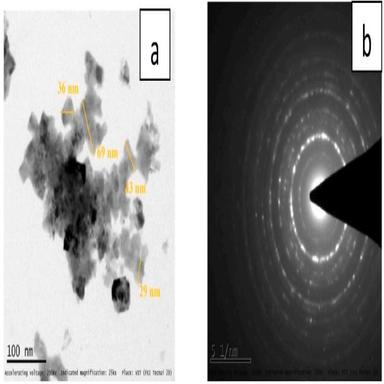
(a) TEM micrograph and SAED pattern of LSMN7382 nanopowder.